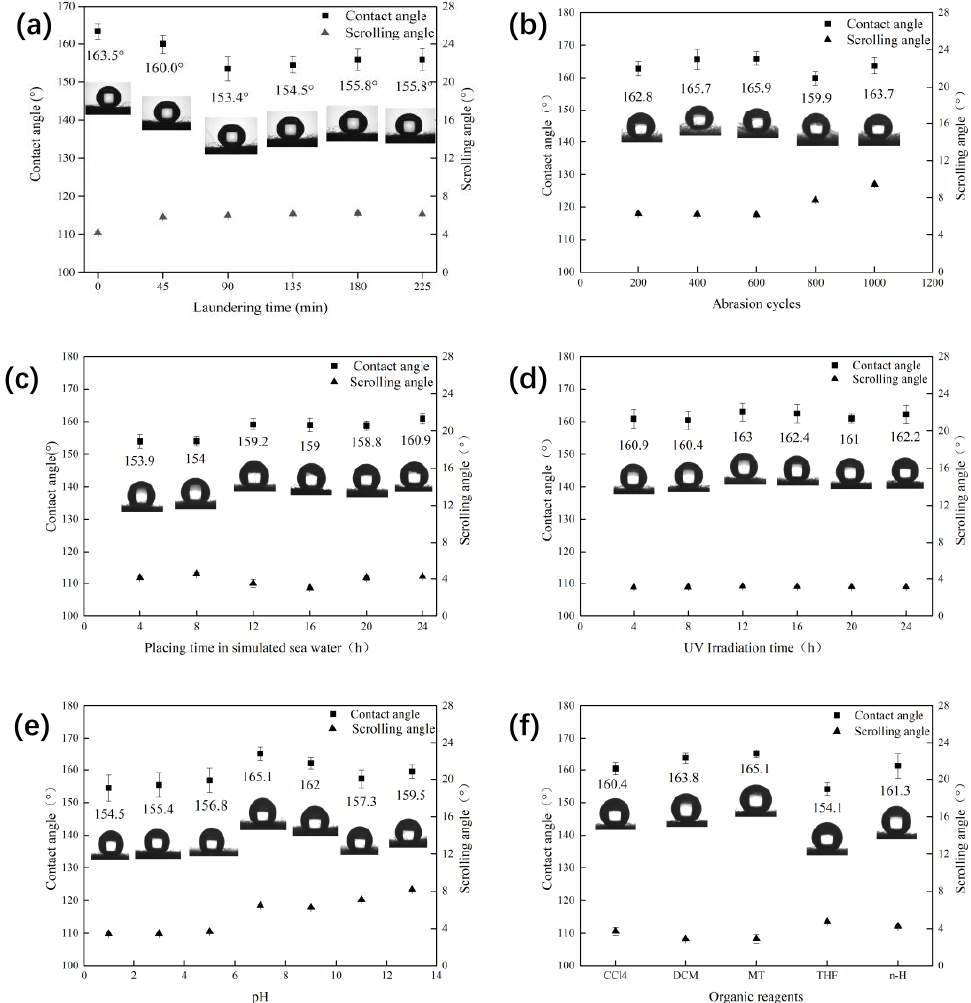
Figure 6. Superhydrophobic stability of CA-Fe-SH-PET fabric. ( a ) Water washing resistance; ( b ) fric- tion resistance; ( c ) seawater resistance; ( d ) sun aging resistance; ( e ) pH resistance; ( f ) organic reagent resistance.